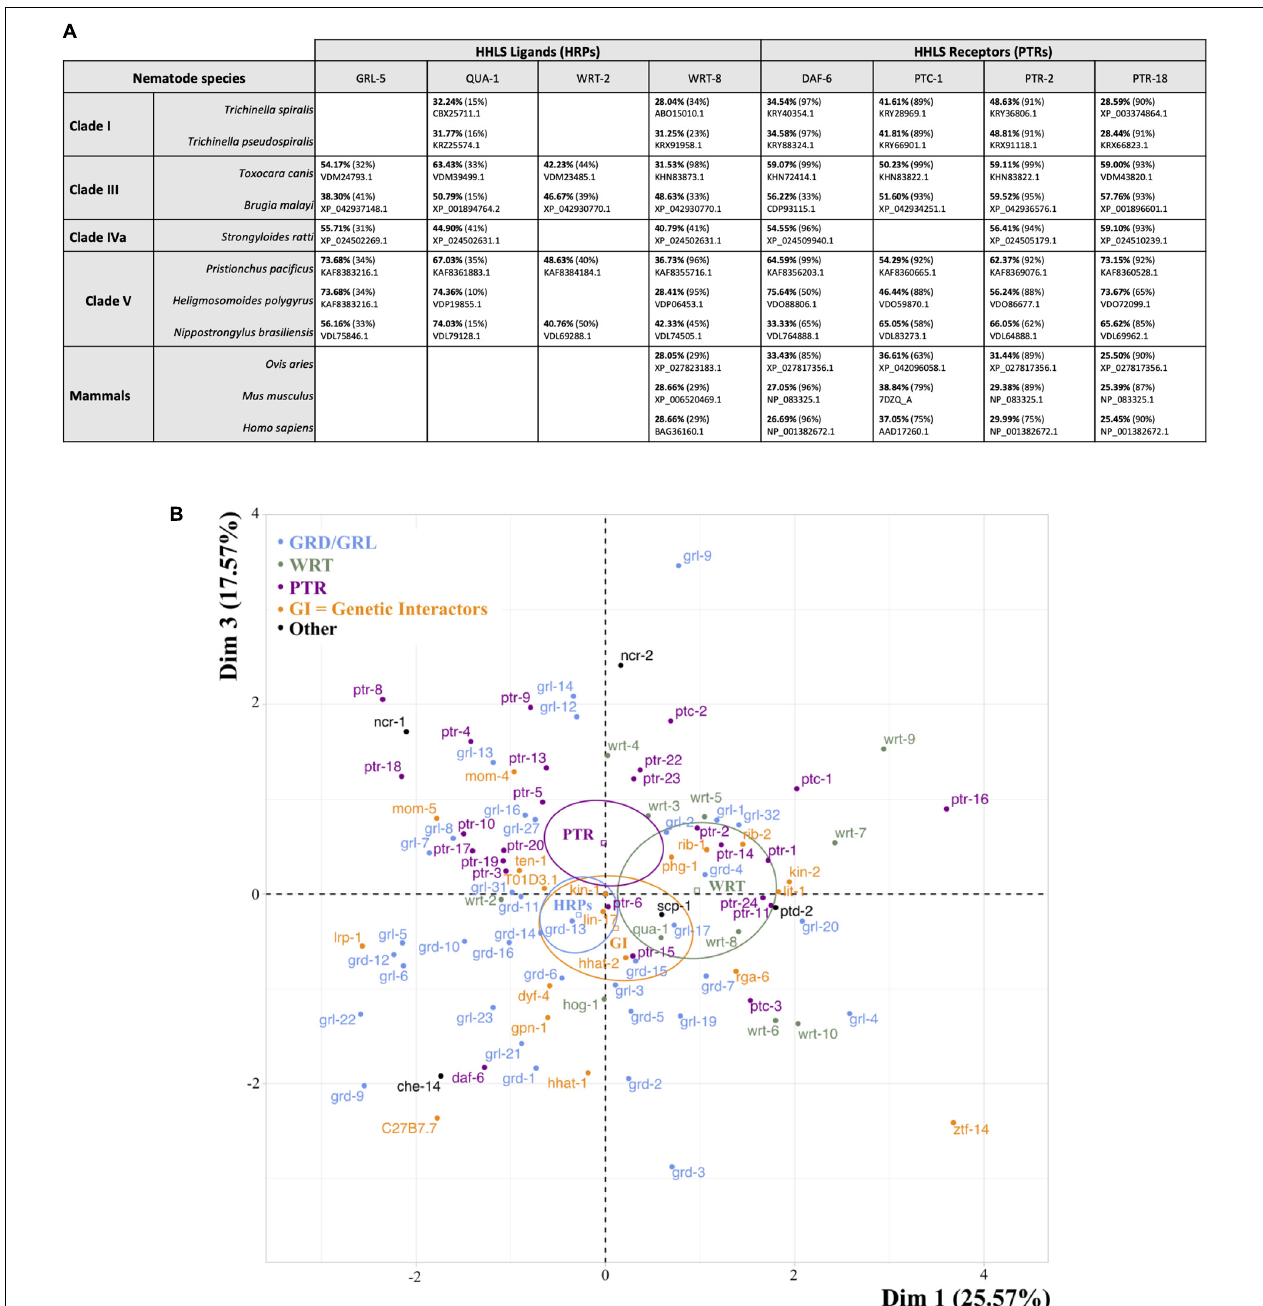
FIGURE 6 | Divergence in sequence identity and differential effects of HHLS pathway gene inhibition on C. elegans phenotypes. (A) Percentage identity (bold) and percentage of sequence coverage (parentheses) for the most-likely orthologs of selected C. elegans HRPs and PTRs across nematode clades and mammals. Accession numbers for proteins are provided below percentage identity. Results were obtained using BLASTP or TBLASTN of C. elegans protein against target species databases. Low sequence identities between species suggest that targeting nematode HHLS pathway genes could be a valid strategy for species-specific interventions and may be unlikely to disrupt mammalian host Hedgehog signaling. (B) Scaled Principal Component Analysis (PCA) of individuals applied to survival data from C. elegans exposed to RNAi targeting HHLS genes (median times of death in stress and infection assays from Figures 3B,C ). The plot highlights clusters of RNAi conditions that lead to similar outcomes in the phenotypic assays performed. Dimensions 1 and 3 spread variables in a meaningful manner (Dim 1 against Dim 2 is provided in Supplementary Figure 6 ). Dim 1 recapitulates variation in stress resistance and separates GRL/GRD from WRT ligands, while Dim 3 spreads data mainly according to resistance to infection and seems to separate PTR genes from reported genetic interactors of the C. elegans HHLS pathway (GI). “Other” regroups highly conserved non-PTR genes coding for sterol sensing domain proteins: ptd-2, che-14 (Dispatched orthologs), ncr-1, ncr-2 (NPC1 orthologs), and scp-1 (SCAP ortholog). RNAi clusters may reveal HHLS genes that are co-engaged in a response or a degree of functional redundancy. Overall, effects of individual HRPs and PTRs vary significantly.